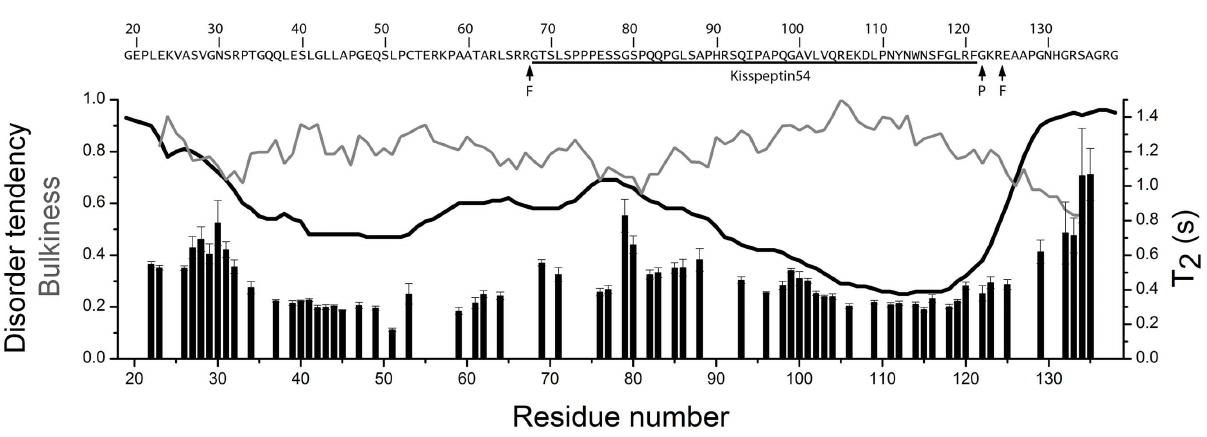
Fig 1. Amino acid sequence featuresand backbone dynamics of KISS1. The sites of proteolytic processing by furin are indicatedwith arrows F. The site of peptidyl-glycine- α -amidating monooxygenase (PAM) action that converts G122 into an amide is indicatedby arrow P. The black line shows the predicted disordertendency(left axis), the grey line shows the normalized bulkinessalong the polypeptidechain (left axis), and the bars show the backboneamide 15 N T 2 relaxation times (right axis). The bulkinesswas calculatedwith the ProtScale tool in the expasy web server (http://web.expasy.org/protscale/)with a windowsize of 9.